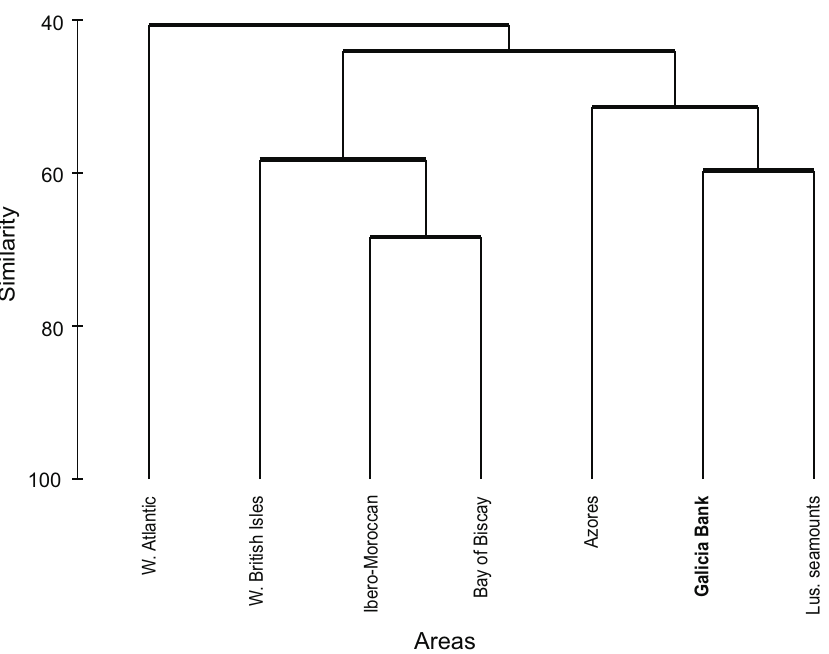
Fig. 49. Similarity between Galicia Bank and other areas of the North Atlantic, based on presence/ absence data of molluscan species and on the Bray-Curtis similarity index. Areas as on Fig.